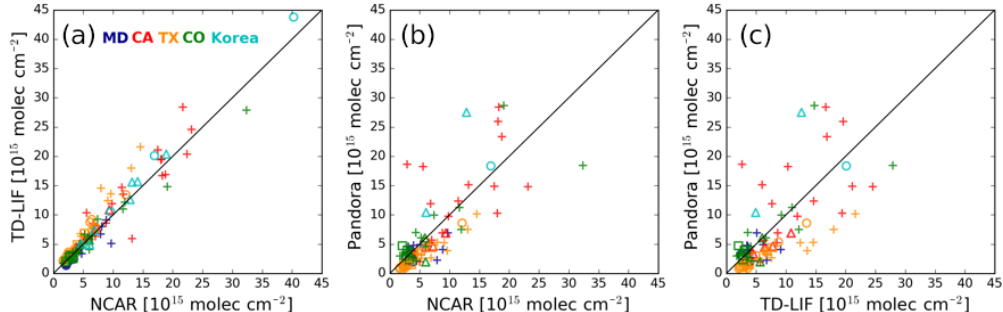
Figure 6. Comparison of NO 2 tropospheric columns derived from NCAR, TD-LIF, and Pandora instruments. Different colors represent the campaign location, and the symbols represent the type of surface monitor (open circle: photolytic converter, plus: molybdenum converter, triangle: CAPS, square: CRDS).